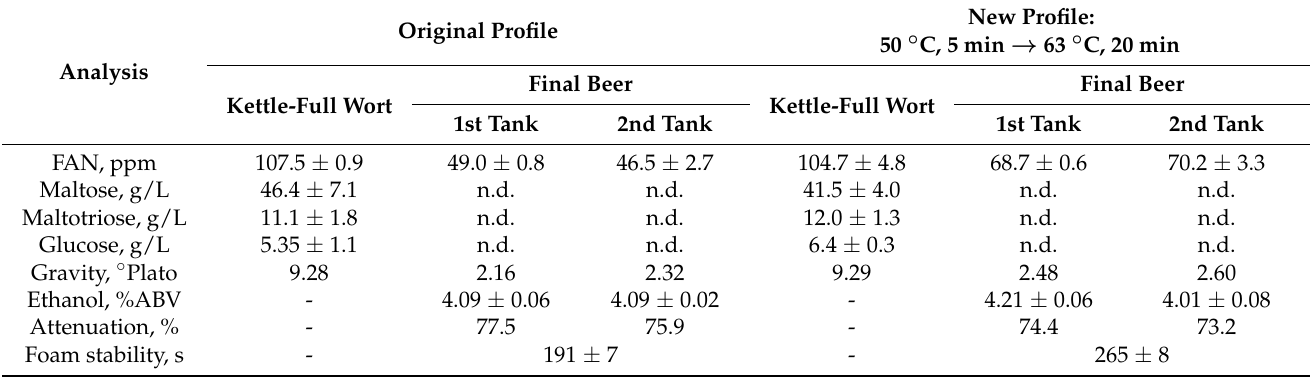
Table 4. Pilot scale wort and beer analysis (average ± standard deviation). n.d. = not